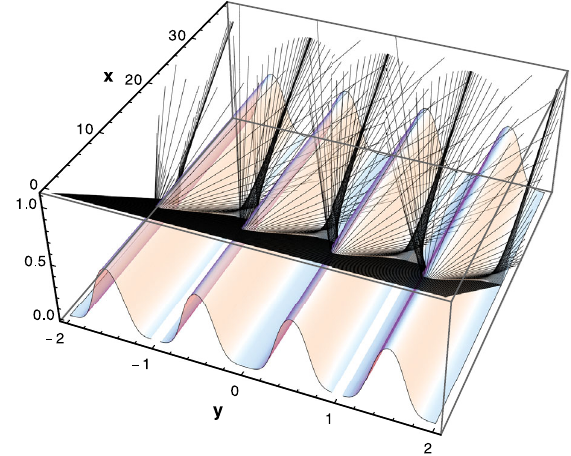
FIG. 32. Illustration of scattering from a grooved surface. For correspondence with the measured groove structure shown in Fig. 9,one distance unitcorrespondsto 5 μ m. Therays are incident with a grazing angle of 3°, and the groove depth is about 2 . 5 μ